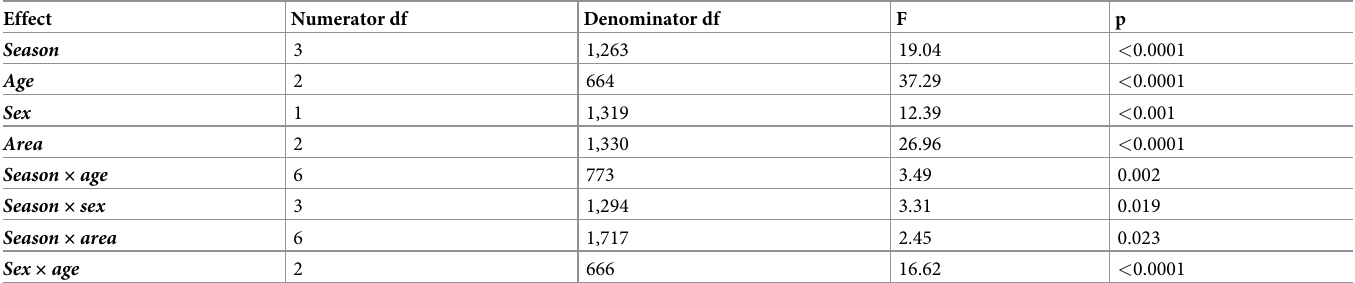
Table 2. Summary of the linear mixed